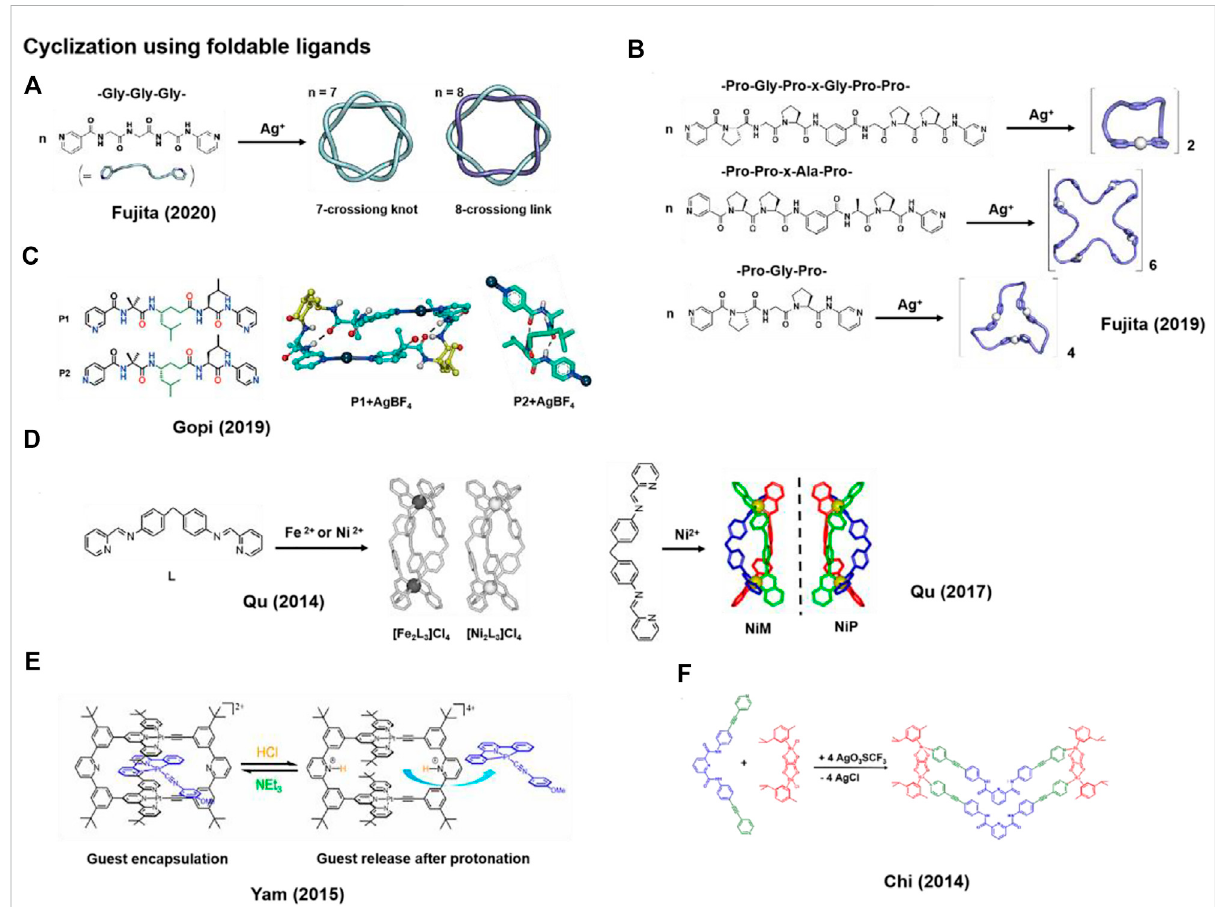
FIGURE 1 Representative metal-coordinated macrocycles synthesized using foldable ligands. (A,B) Macrocyclization via coordination between Ag + and foldablepeptides; (C) Structuresoffoldedpeptides P1 and P2 ,andthecrystalstructuresof P1 +Ag + (2+2macrocycle)and P2 +Ag + complexes; (D – F) Structuresofligandscontainingaromaticringandpyridinegroupsforthecoordinationwithmetal ionstoformmacrocycles; (D) Structuresofligand L , M -and P -enantiomercoordinatedwithFe 2+ orNi 2+ toform [Fe 2 L 3 ]Cl 4 , [Ni 2 L 3 ]Cl 4 , NiM and NiP ; (E) pH-responsivePt 2+ directedmacrocycles; (F)